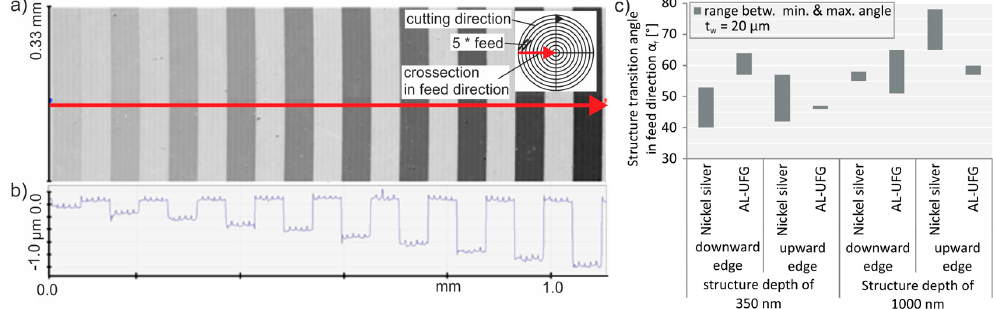
Figure 8. ( a ) With light interferometric measurement of the structure transition in the feed direction, ( b ) a linear cross section, and ( c ) the structure transition angle in the feed direction.